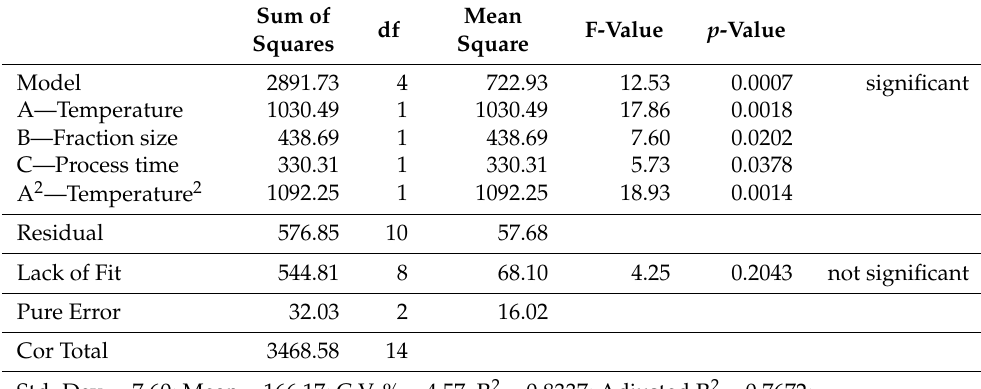
Table 5. The analysis of variance for polyphenols content.